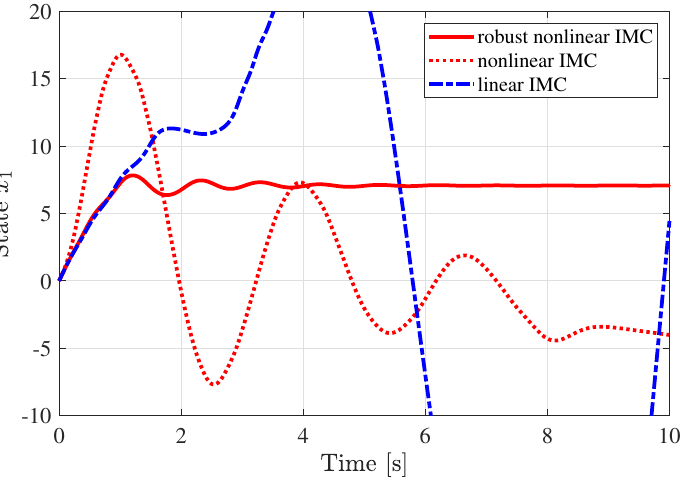
Figure 7. Controlled state x 1 achieved by the proposed IMC, the nonlinear IMC, and the linear IMC.